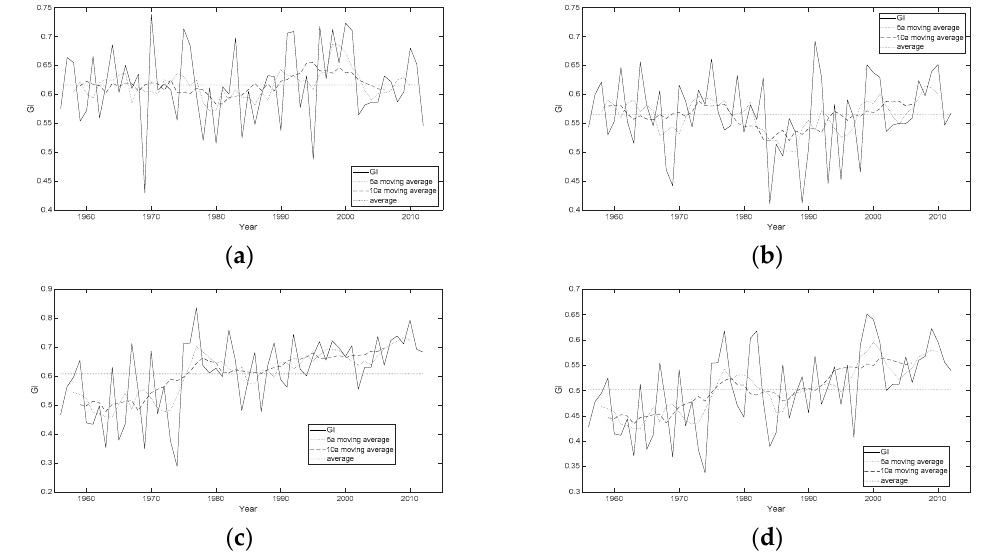
Figure 4. The values and their moving average of the Gini coefficient (GI) from 1965 to 2012: ( a ) Baoqing station, ( b ) Baoan station, ( c ) Hongqiling station, and ( d ) Caizuizi station. Note: 5a moving average is a moving average of 5 years, and 10a moving average is a moving average of 10 years.